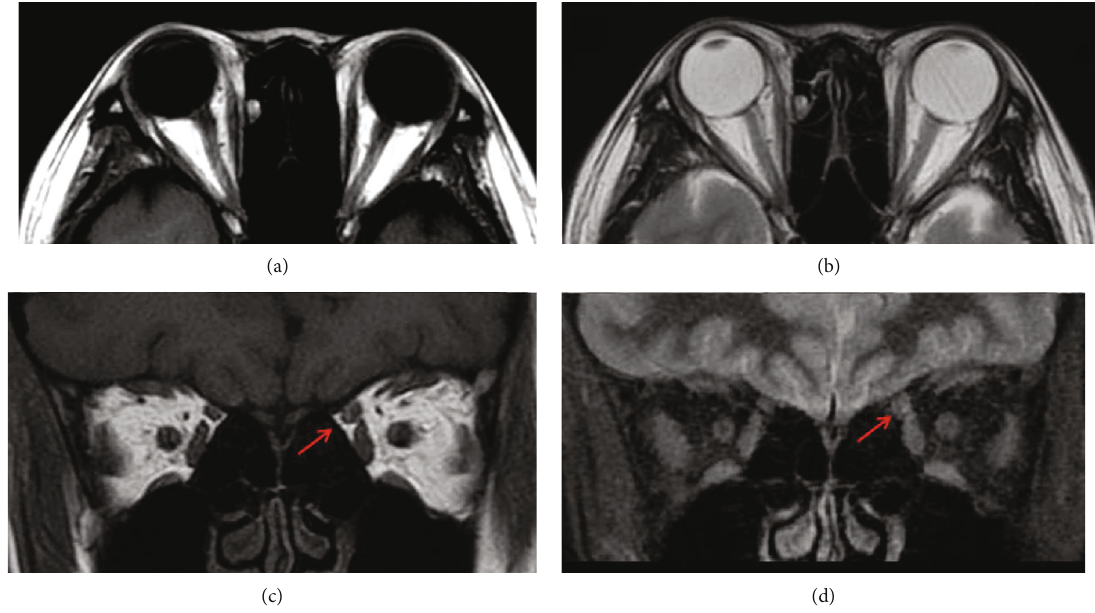
Figure 2: Magnetic resonance imaging (MRI) scans of the patient. The images showed a slight enlargement of the superior oblique muscle of the left eye (red arrow); however, neither enlargement nor abnormal signals were seen in the other four extraocular rectus muscles in either eye: (a) axial T1-weighted image, (b) axial T2-weighted image, (c) coronal T1-weighted image, and (d) coronal Short Tau Inversion Recovery (STIR) image.